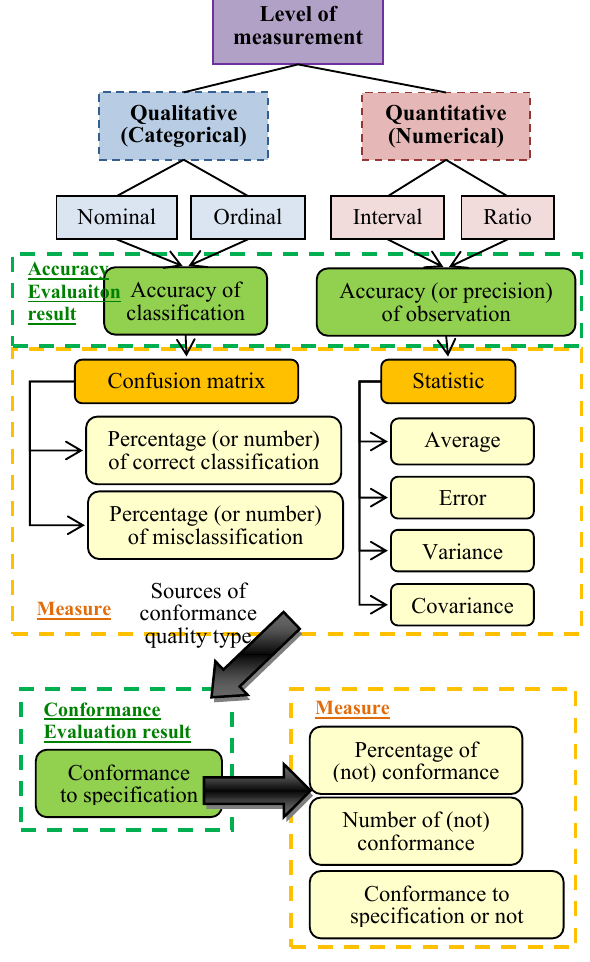
Figure 5. Relationship between levels of measurement, quality evaluation result and possible